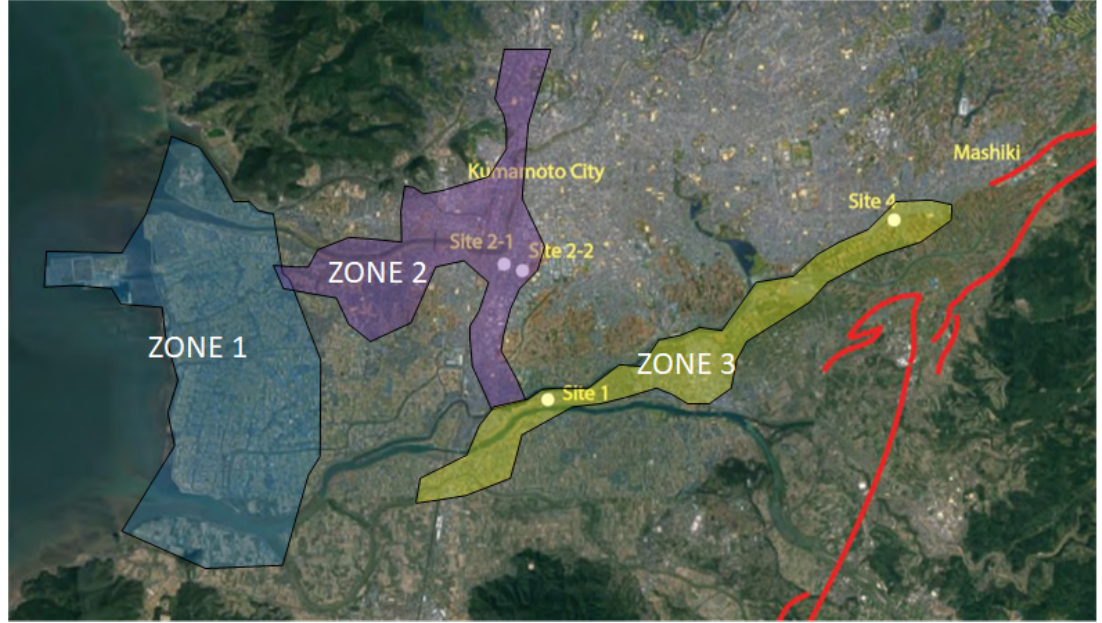
Figure 8. Site vicinity map showing the four sites investigated in 2017 as part of this study (after Anderson [40]). Red lines denote faults, and the colored zones represent Zones 1, 2, and 3.